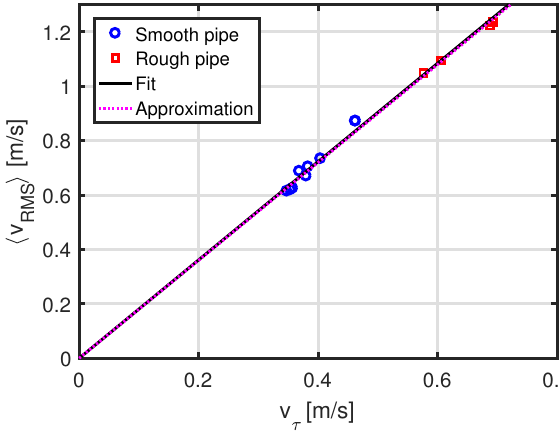
Figure 8. Relationship between friction velocity and the average velocity of the turbulent